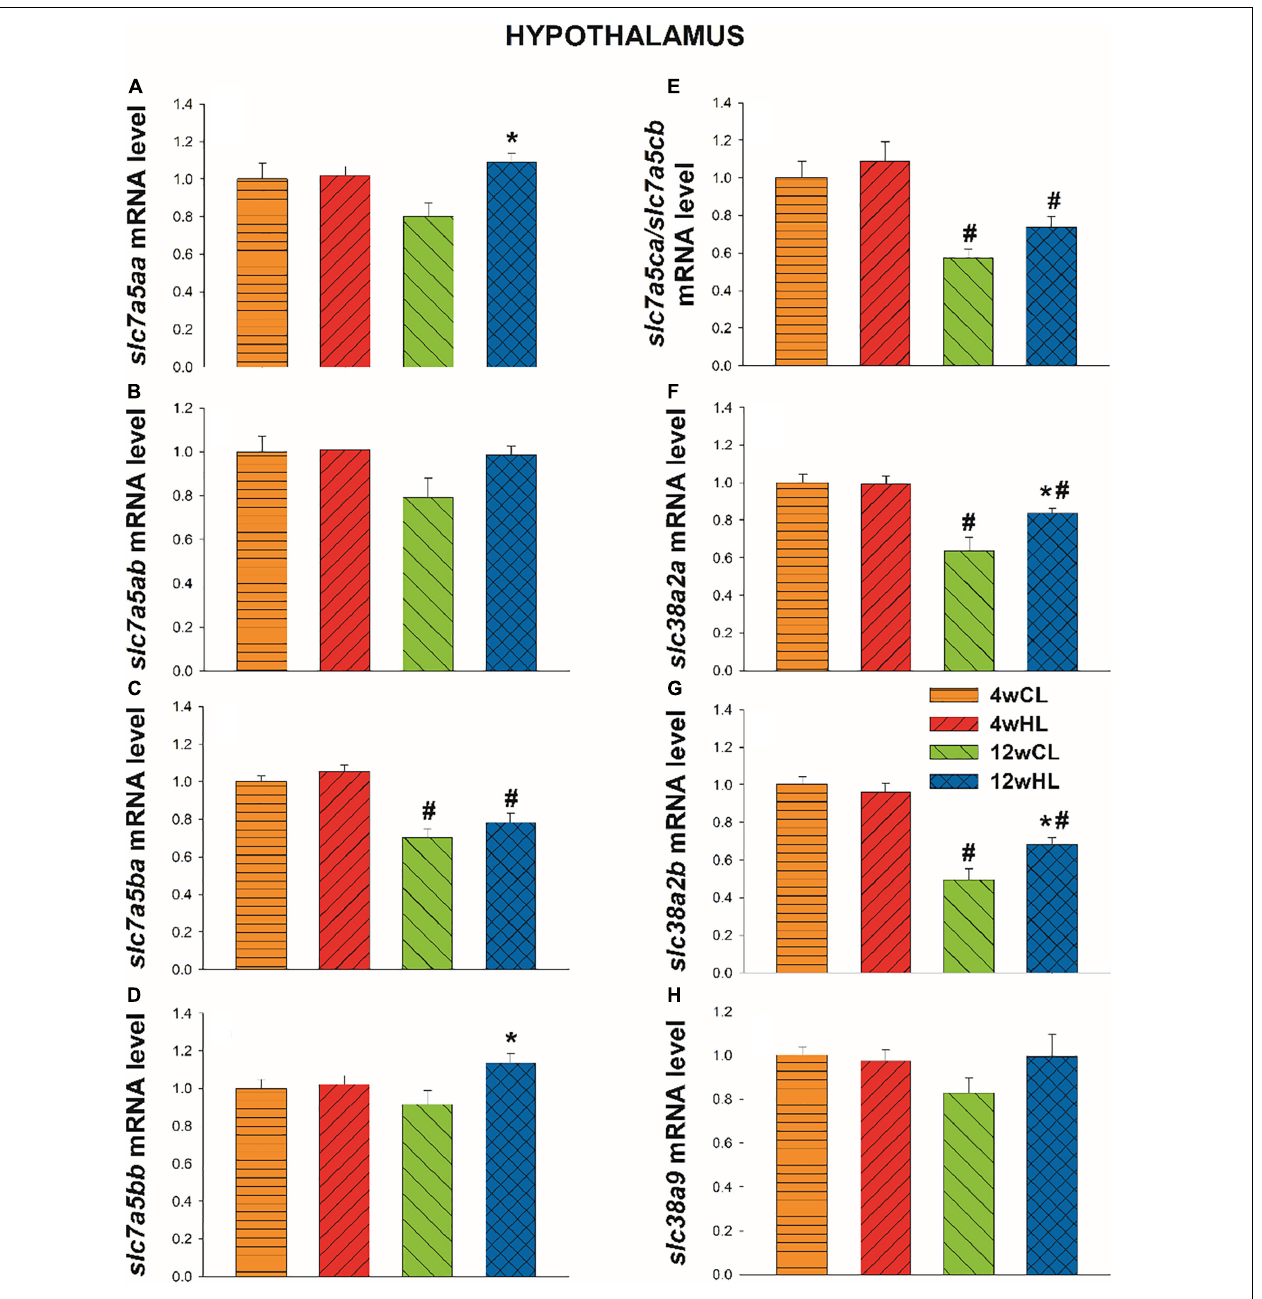
FIGURE 6 | Hypothalamus mRNA level of slc7a5aa (A) , slc7a5ab (B) , slc7a5ba (C) , slc7a5bb (D) , slc7a5ca / slc7a5cb (E) , slc38a2a (F) , slc38a2b (G) , and slc38a9 (H) of Atlantic salmon after four (4w) or twelve (12w) weeks of feeding with control leucine diet (CL; 27.3 g/kg) or high leucine diet (HL; 35 g/kg). Each value is the mean ± SEM of n = 12 samples per tissue. Gene expression results are relative to fish fed CL for 4w and are normalised by actb ( β -actin). *, significantly different ( P < 0.05) from fish fed with LL within the same time. #, significantly different ( P < 0.05) from fish fed for 4 weeks with the same